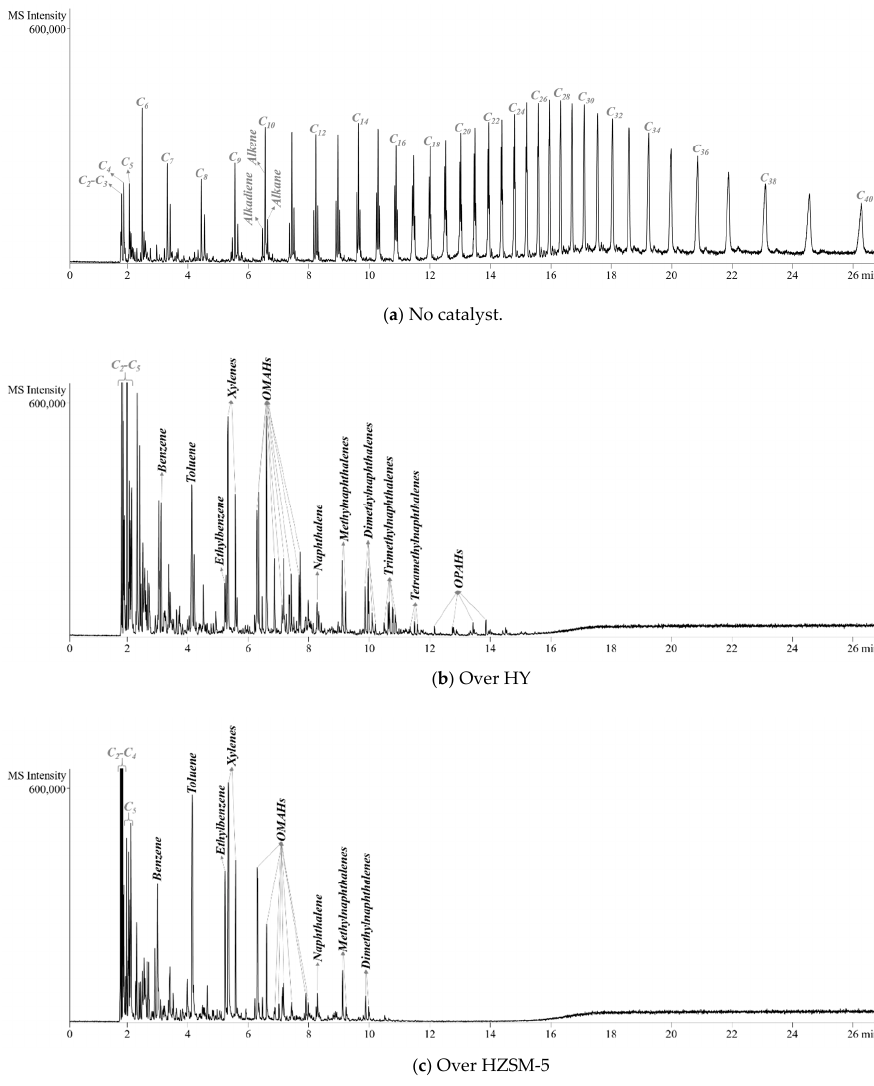
Figure 5. MS chromatograms obtained from the NCFP and CFP of HDPE over HY and NZSM-5 at 600